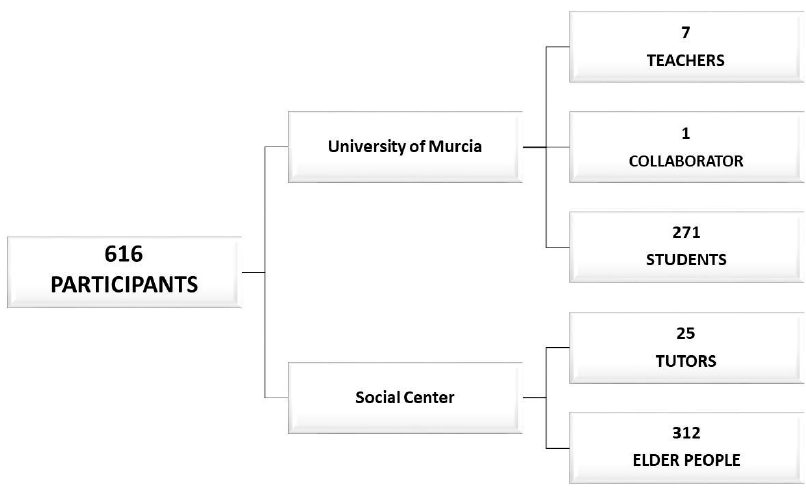
Figure 1. Participants from the academic course 2018/2019. Table 1. Sample description (N =